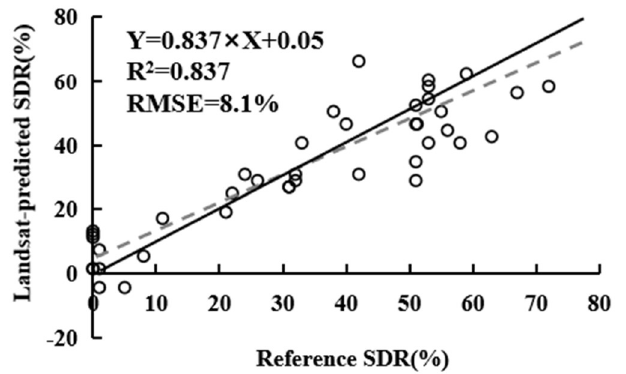
Figure 4. Comparison between reference (i.e., from field plots) and Landsat-predicted percent shoot damage ratios within 30-m grid cells using linear regression models. Solid line is the regression line; gray dashed line is the 1:1 line; RMSE, root mean square error. SDR: shoot damage ratio.